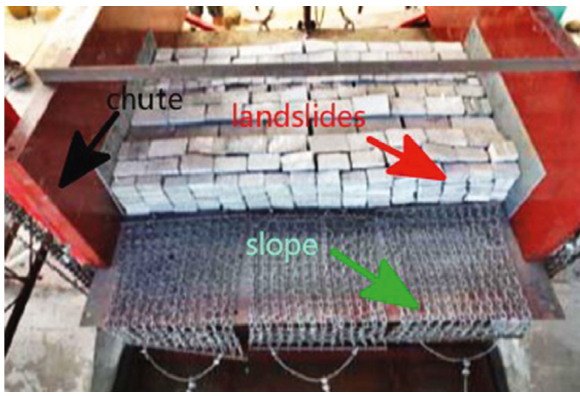
Figure 6: Arrangement of sliding Table 3: Operating of the test.